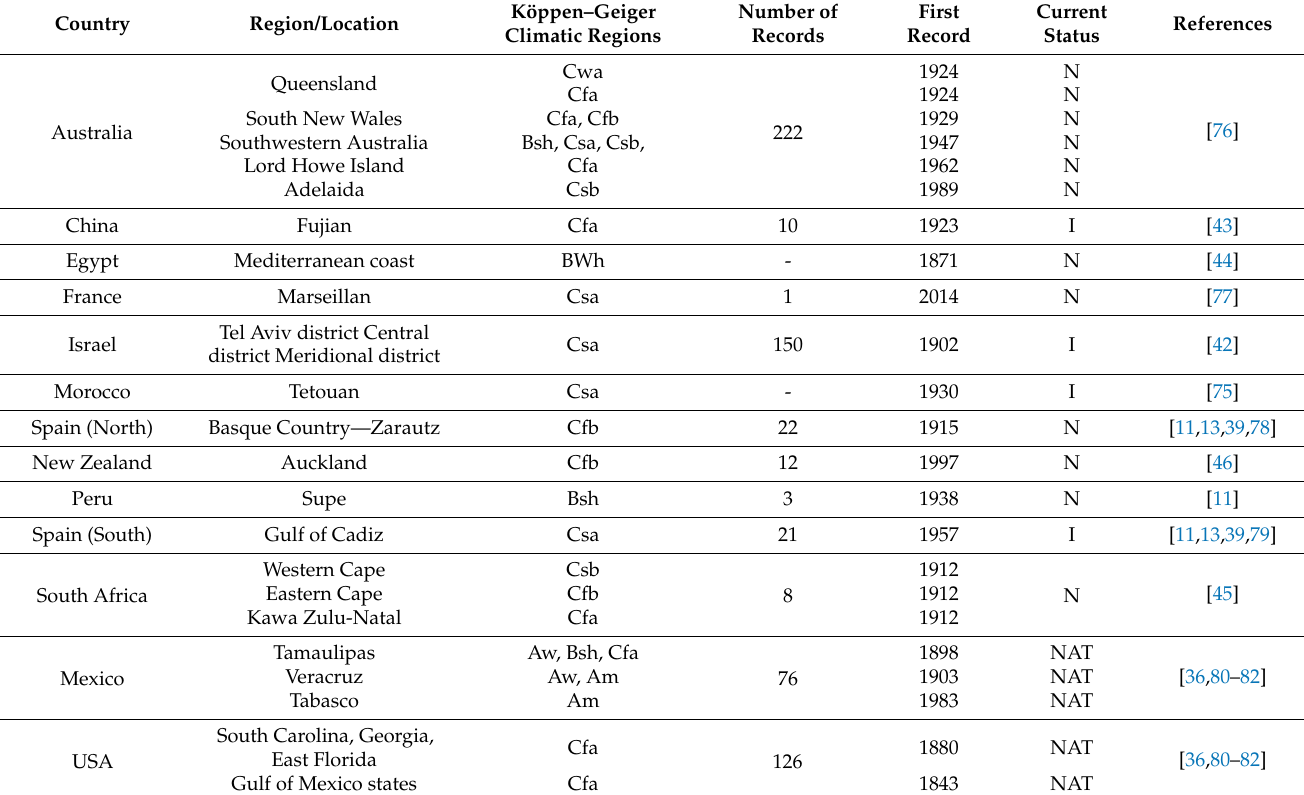
Table 3. Worldwide distribution of Oenothera drummondii subsp. drummondii . White rows indicate non-native distributions where N: naturalized, I: invasive. Gray rows indicate native distribution (NAT: native). Köppen–Geiger climatic native regions: Tropical monsoon climate (Am), Tropical savanna climate with dry-winter characteristics (Aw) hot semi-arid climate (Bsh), and Humid subtropical climate (Cfa). Köppen–Geiger climatic non-native regions: Mediterranean hot summer climates (Csa), Mediterranean warm/cool summer climates (Csb), Temperate oceanic climate (Cfb), Dry-winter humid subtropical climate (Cwa) and Hot desert climate (BWh). Köppen–Geiger Country Region/Location Climatic Regions